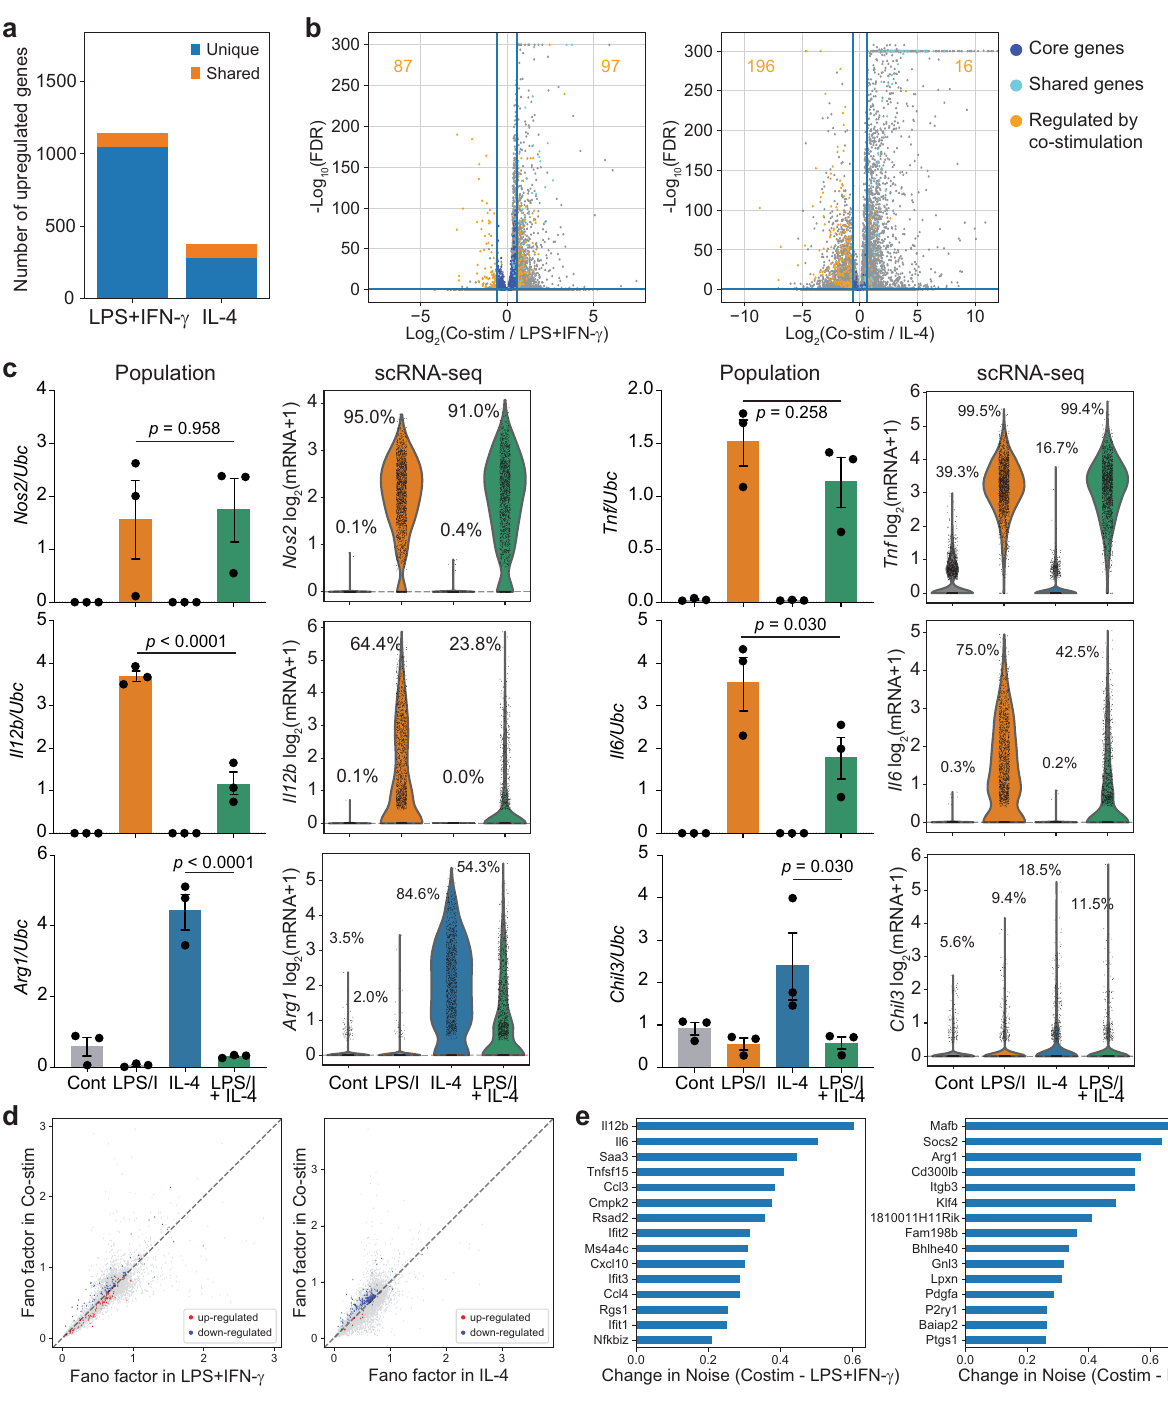
Fig. 2 Cross-inhibition of gene expression after co-stimulation is not uniform across single cells. a Number of unique (blue) and shared (yellow) genes upregulated after stimulation (6 h, 10 ng/ml LPS + 10 ng/ml IFN- γ or 100 ng/ml IL-4). b Volcano plot of differential gene expression after co-stimulation (6 h, 10 ng/ml LPS + 10 ng/ml IFN- γ and 100 ng/ml IL-4) relative to LPS + IFN- γ alone (left) and IL-4 alone (right). Dark blue dots (see key) indicate the unique core genes (UCGs) selectively induced by LPS + IFN- γ or IL-4, respectively. Cyan dots indicate shared genes induced by both LPS + IFN- γ or IL-4. Yellow dots indicate UCGs modulated by co-stimulation, identi fi ed by an FDR ≤ 0.05 and change in expression ≥ 1.5-fold relative to expression after stimulation with LPS + IFN- γ or IL-4 alone. FDR determined as in Fig. 1. c Transcript levels for indicated targets in BMDMs after stimulation for 6 h with media alone, LPS + IFN- γ , IL-4, or both, measured by population RT-qPCR (left) and scRNA-seq (right). Population mRNA levels are presented relative to those of the control gene Ubc (mean ± SEM, n = 3 biological replicates). Two-sided one-way ANOVA with Sidak correction for multiple comparisons. Single-cell data is presented as the ln(transcript count + 1) from a single experiment. d Noise in gene expression (calculated by Fano factor) across single cells stimulated with LPS + IFN- γ versus co-stimulated cells (left) or IL-4 vs co-stimulated cells (right) for genes negatively (blue) and positively (red) regulated by co-stimulation. e Change in cell-to-cell gene expression noise of LPS + IFN- γ -induced genes (left) and IL-4-induced genes (right) in co- stimulated cells relative to single stimulation. Source data are provided as a Source Data fi